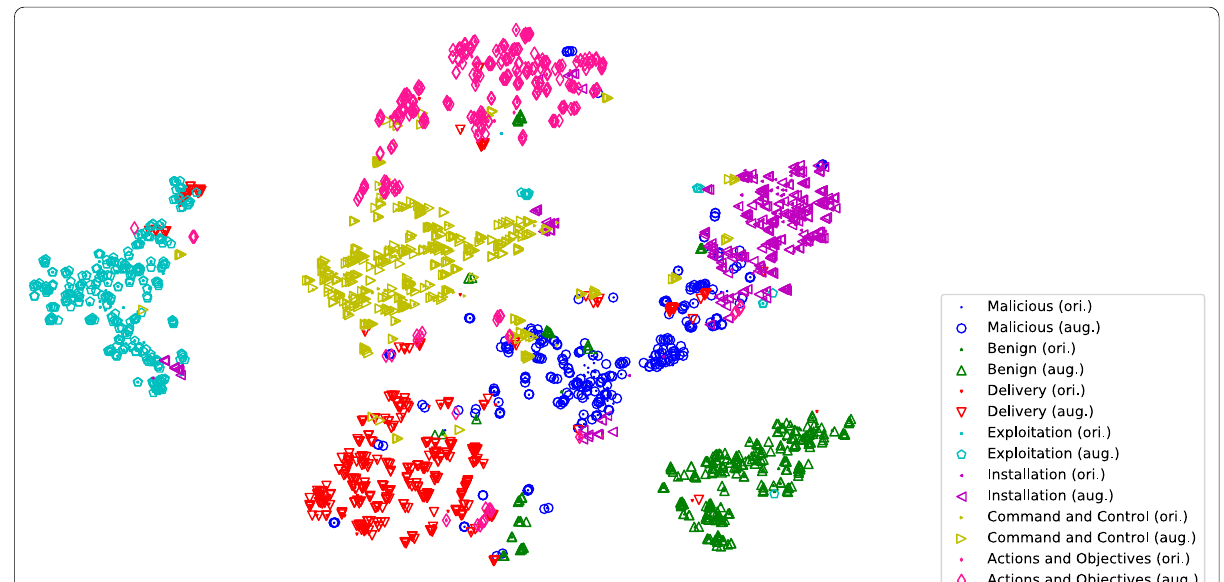
Fig. 7 Case study 1. The visualization of the latent space representations for original training set (smaller size symbol) and augmented training set (large size symbol). The same campaign stages have the same colors